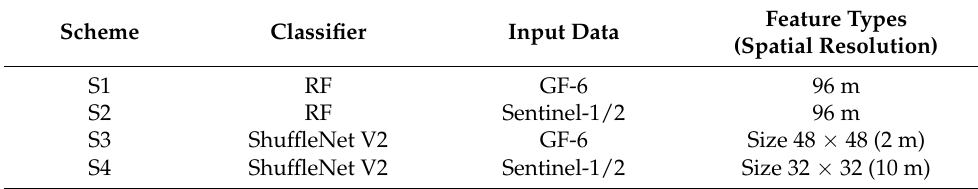
Table 3. Comparative scheme